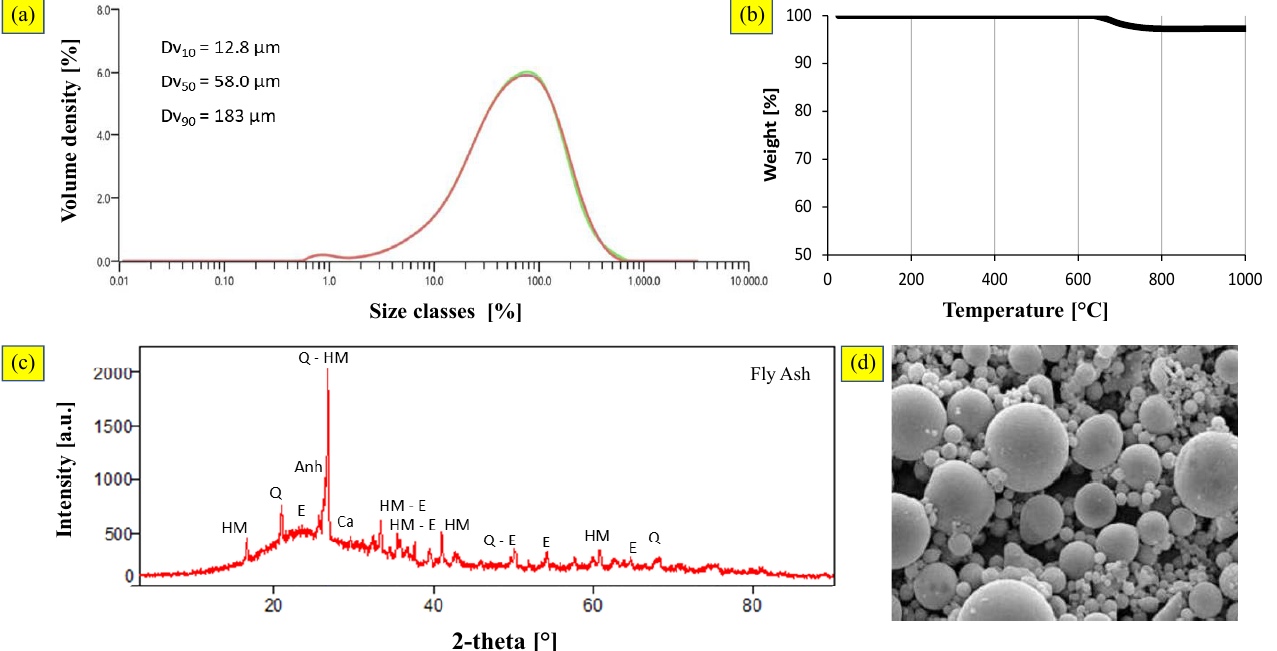
Figure 3. Coal fly ash: ( a ) particle size distribution; ( b ) TGA curves; ( c ) X-ray diffraction pattern; ( d ) SEM image (scale 1000:1).